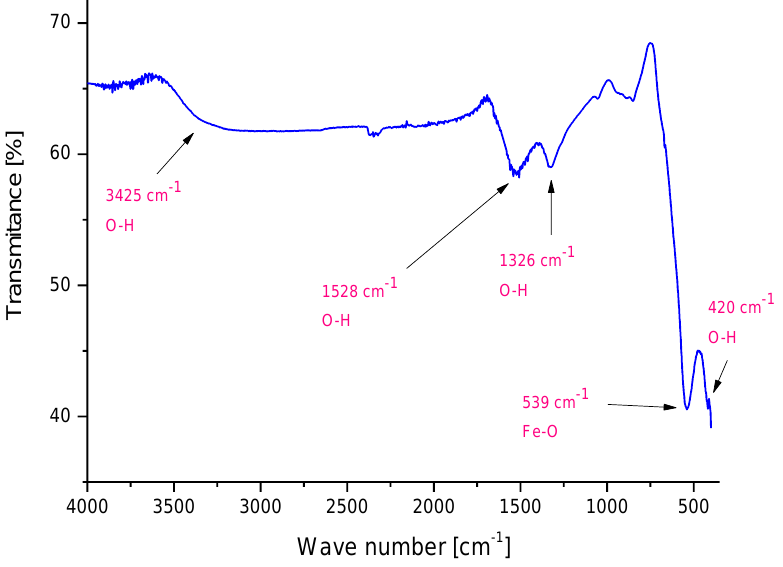
Figure 2. FT-IR (Fourier Transform Infrared Spectroscopy) spectrum of Fe 3 O 4 particles. FT-IR analysis enabled us to determine the presence of characteristic groups in the tested material based on their vibration under the influence of the specific wavelength from the infrared range. On the FT-IR spectrum presented Figure 2, bands at 539 cm − 1 and 420 cm − 1 corresponding to the stretching vibrations of Fe–O can be observed